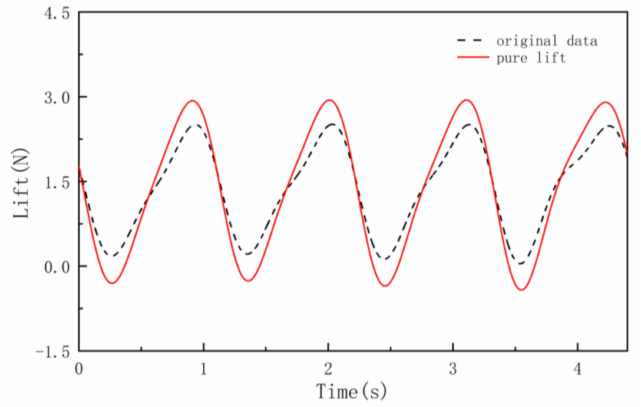
Figure 8. Comparison between the original data and the pure aerodynamic lift force (morphing part length b/3, AOA 4 ◦